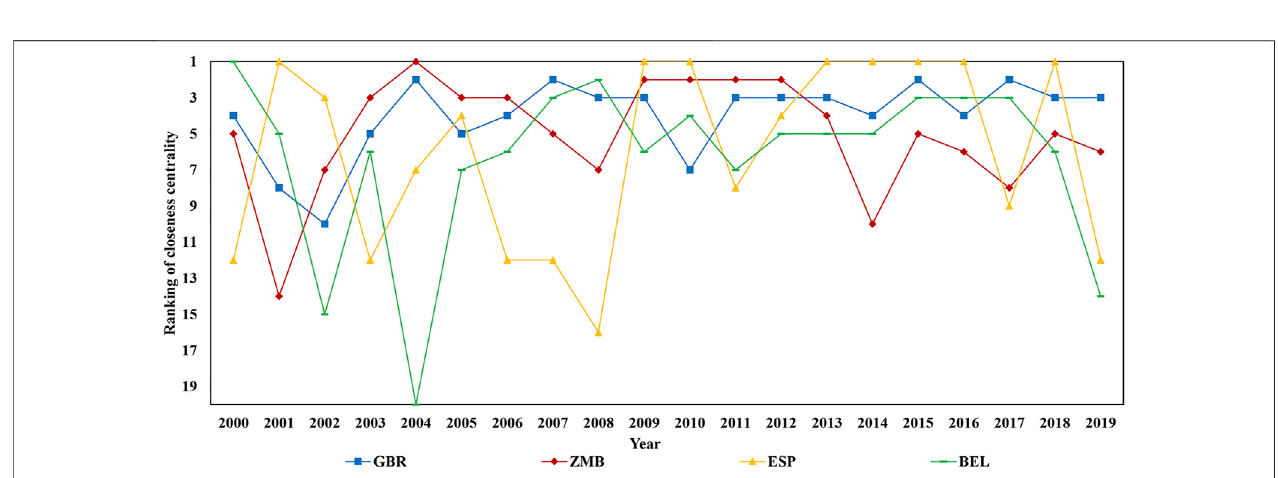
FIGURE 4 | The percentage of each importer ’ s import volumes of cobalt to global import volumes in CIDN from 2000 to 2019.